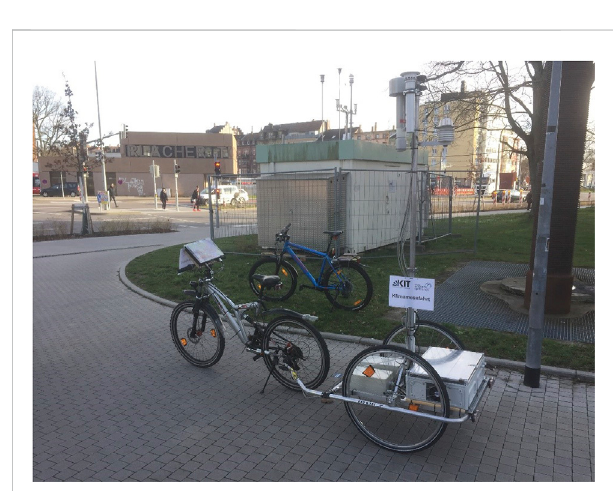
Monitoring bike with sensor systems, lower right box (in the background: the “ Durlacher Tor ” On the trailer, a box was installed containing a low-cost PM sensor (SDS011, Nova Fitness) for measuring PM 2.5 and PM 10 mass concentrations (Budde et al., 2018; Genikomsakis et al., 2018; Liu